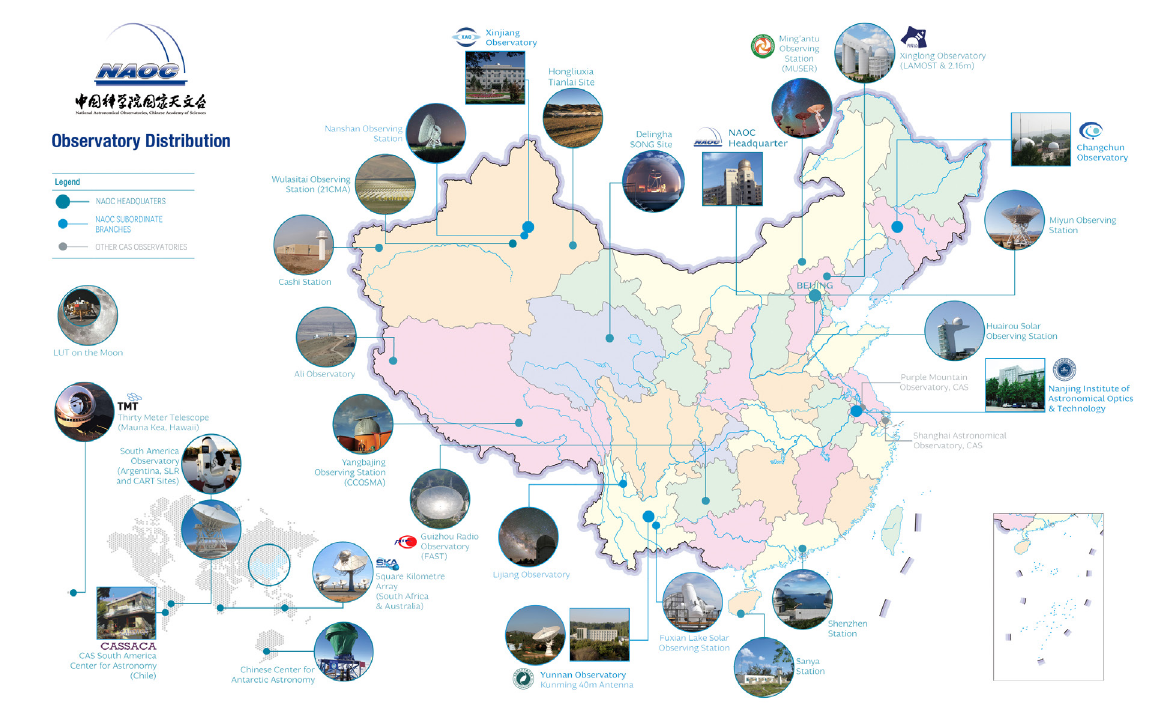
Figure 2. Astronomical Facilities around China and some international collaborative